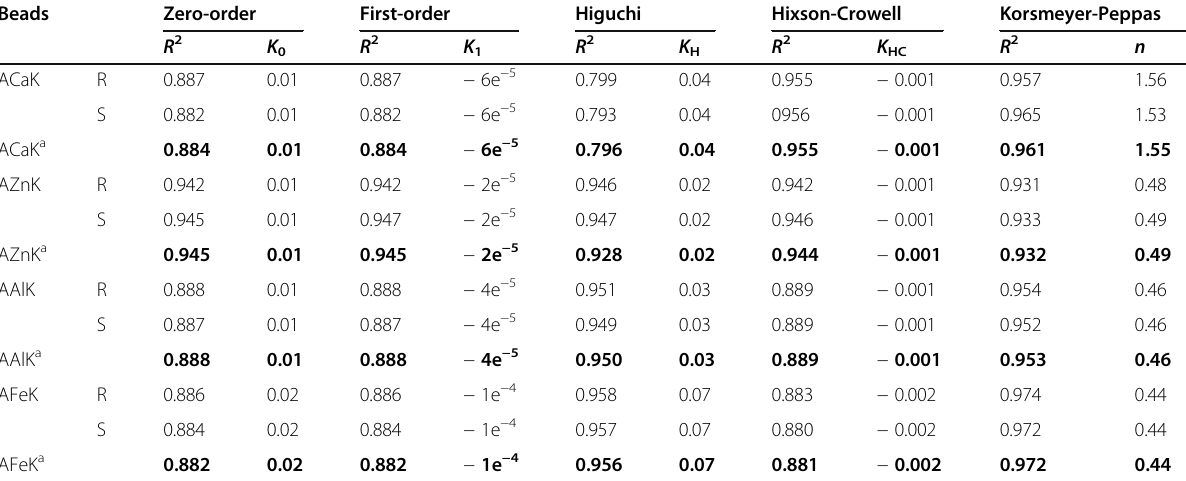
Table 6 Results of modeling KTP release kinetics